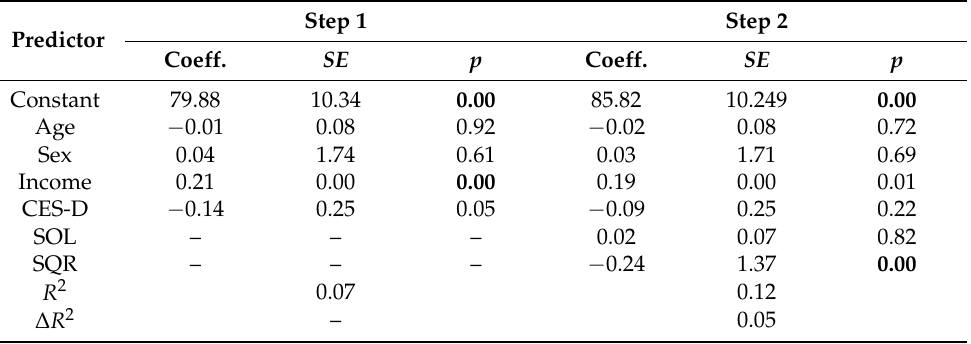
Table 4. Regression analyses of diary-reported indices of sleep in relation to social well-being: N = 213; standardized regression coefficients ( β ); bold font indicates significance; CES-D = Center for Epidemiologic Studies Depression Scale (minus sleep item), SOL = average sleep-onset latency, SQR = average sleep quality rating.